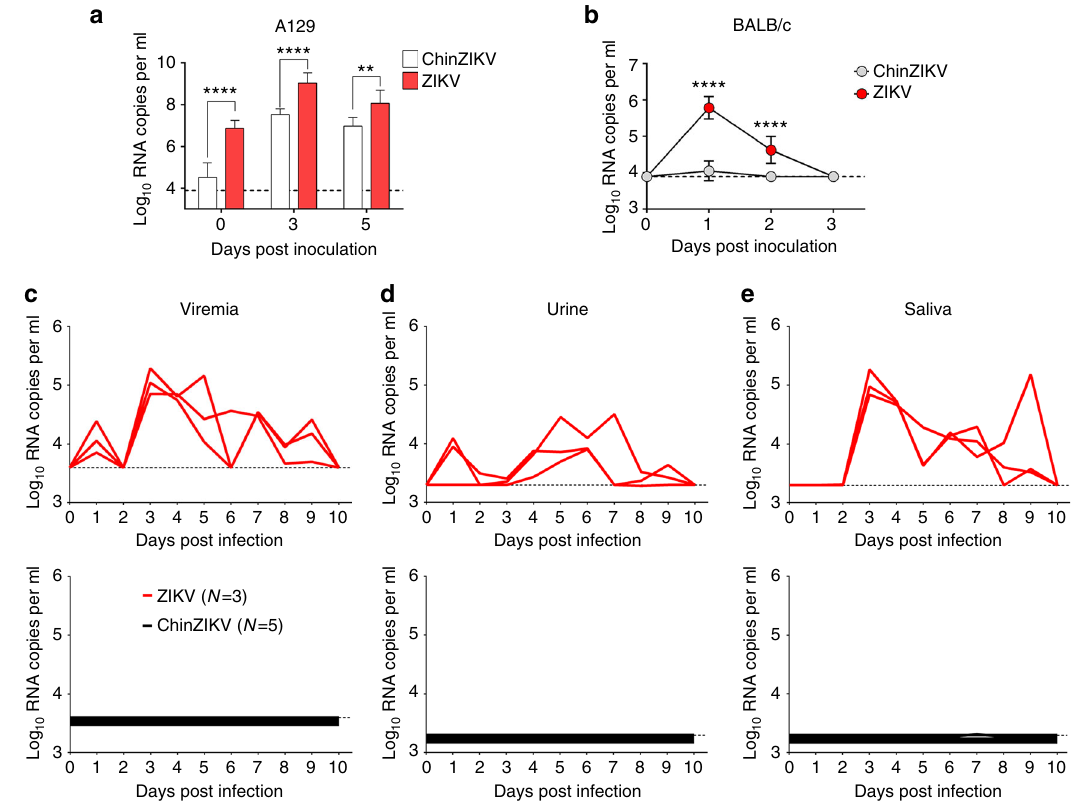
Fig. 2 ChinZIKV is highly attenuated in mice and non-human primates. a , b Viral load in serum in mice inoculated with ChinZIKV or ZIKV. Four-week-old male mice were infected with 10 3 (A129) or 10 5 PFU (BALB/c) of the indicated viruses by the s.c. or i.p. routes, respectively. Viral RNA loads were determined by reverse transcription-quantitative PCR (RT-qPCR). Dotted lines indicate the detection limit. The data are representative of at least three independent experiments, and error bars indicate the SD. Signi fi cance was calculated using a two-way ANOVA with multiple comparison tests a , b (** P - value < 0.01; **** P -value < 0.0001). Viral load in serum c , urine d , and saliva e of monkeys infected with ChinZIKV or ZIKV. Monkeys were infected with 10 5 PFU of ChinZIKV or ZIKV by the s.c. route. Blood and tested fl uids were collected at the indicated times. Viral RNA amounts in the tested samples